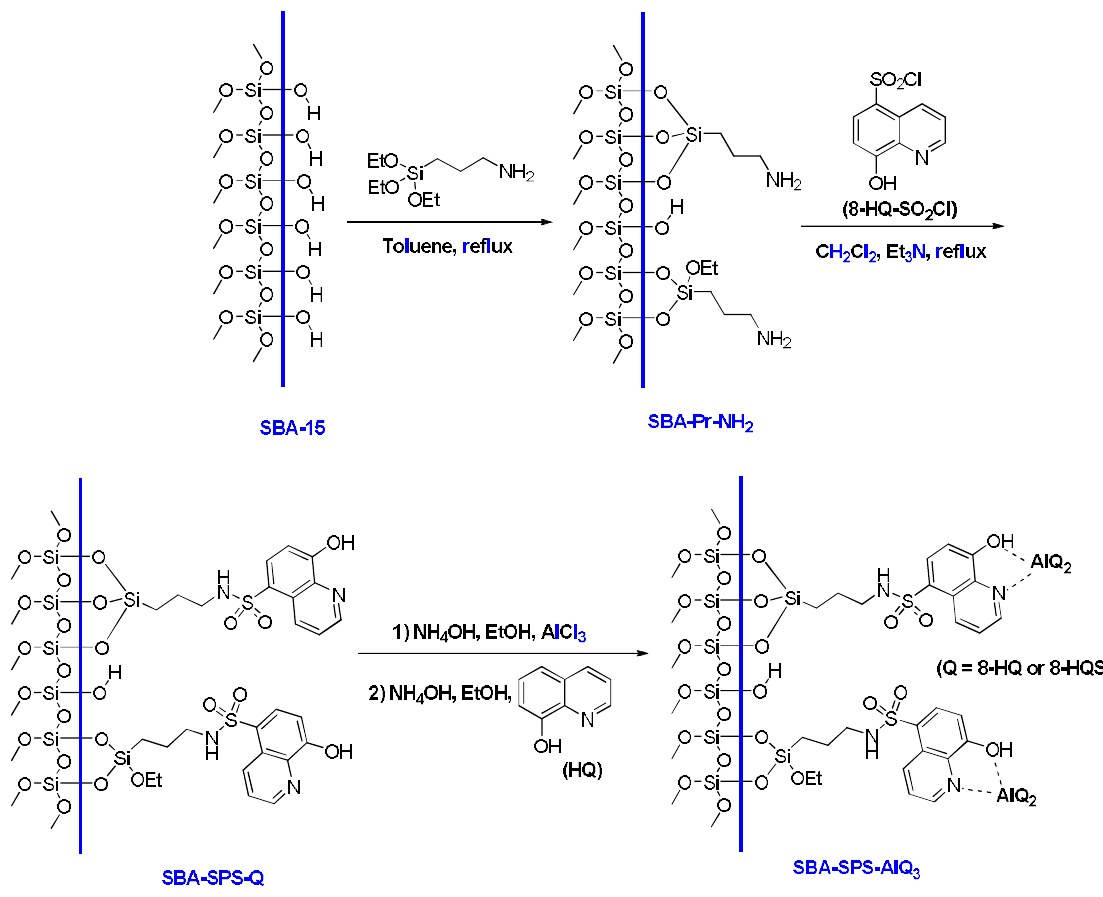
Fig. 1. Synthesis route of SBA-SPS-AlQ